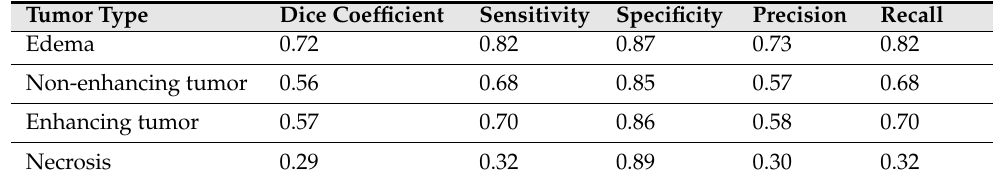
Table 12. Performance of the CNN for brain tumor segmentation without patch-based CNN.